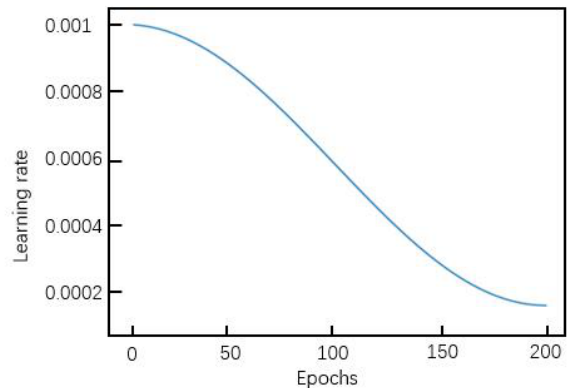
Figure 9. Decay curve of learning